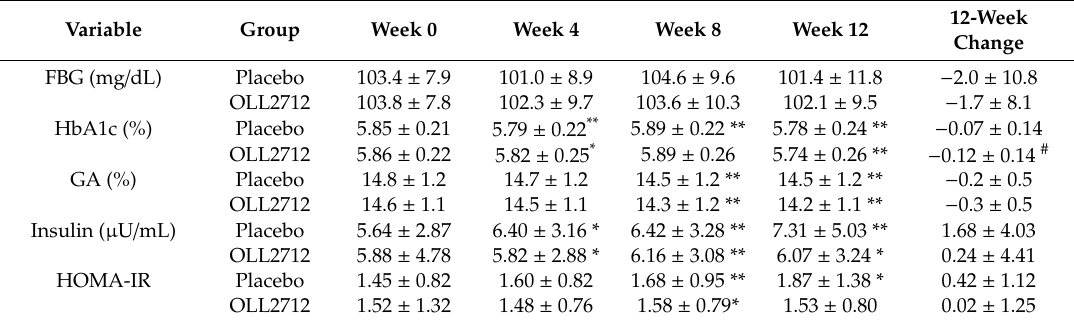
Table 3. Blood biochemical parameters related to glucose metabolism and insulin resistance.